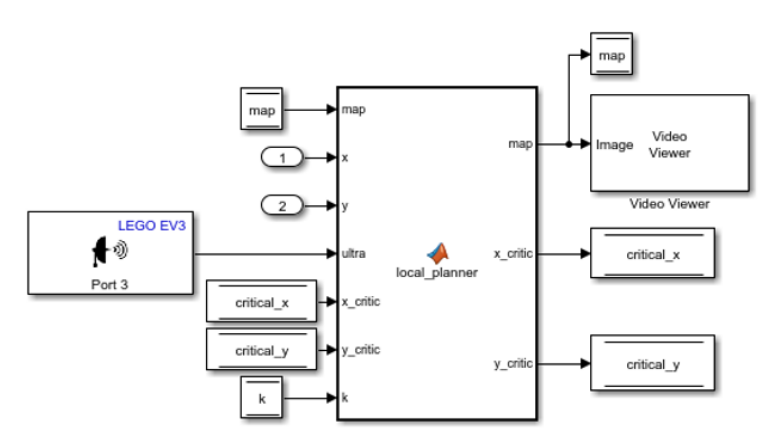
Fig. 3. Local planner block